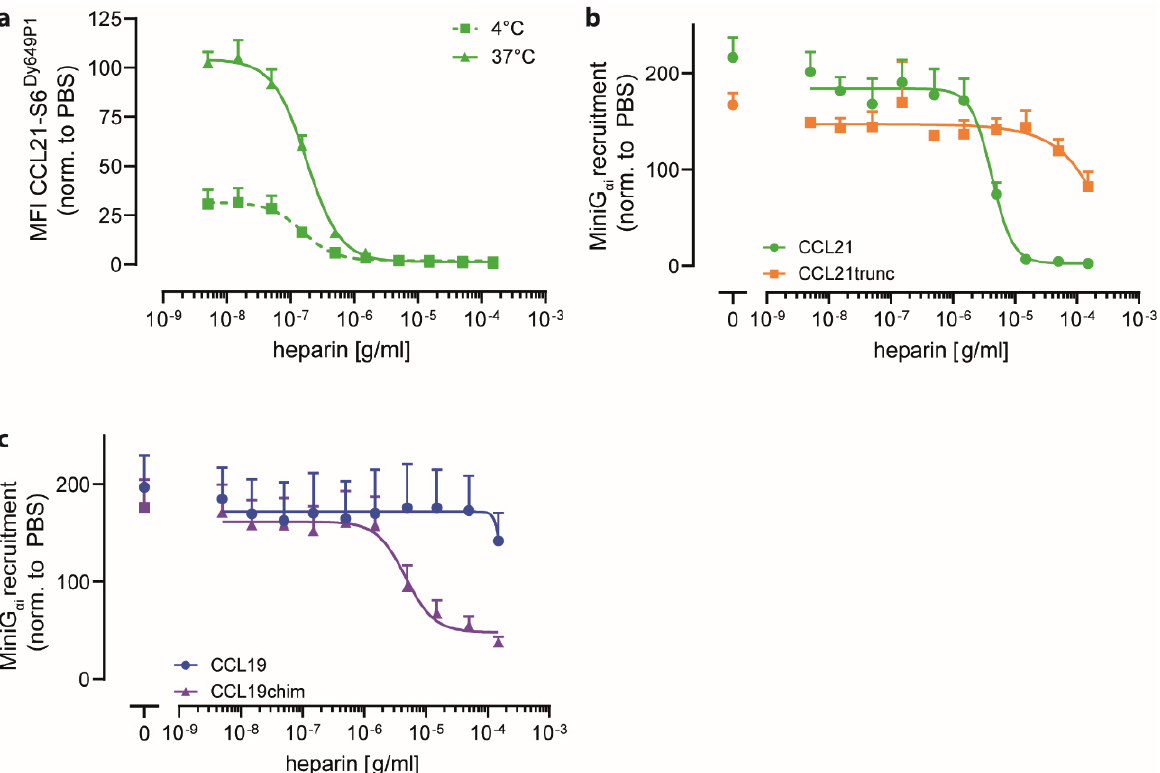
Figure 4. Soluble heparin interacts with CCL21 ′ s C-terminus and limits chemokine-mediated CCR7 signaling. ( a ) 300-19 pre-B cells stably expressing CCR7 were incubated with 25 nM of fluorescently labeled CCL21-S6 Dy649P1 and increasing concentrations of exogenous heparin for 30 min at 4 °C (dotted line) or 37 °C (solid line). Relative chemokine fluorescence was normalized to cells treated with fluorescent chemokine and PBS. Shown are mean values ± SD of n = 3. ( b , c ) Recruitment of lgBit-MiniG α i to CCR7-NLuc11 upon stimulation with 1 μ M of either CCL21 or CCL21trunc ( b ) or 1 μ M CCL19 and CCL19chim, respectively ( c ), in the presence of increasing concentrations of heparin. Mean AUC values ± SD of three independent experiments.